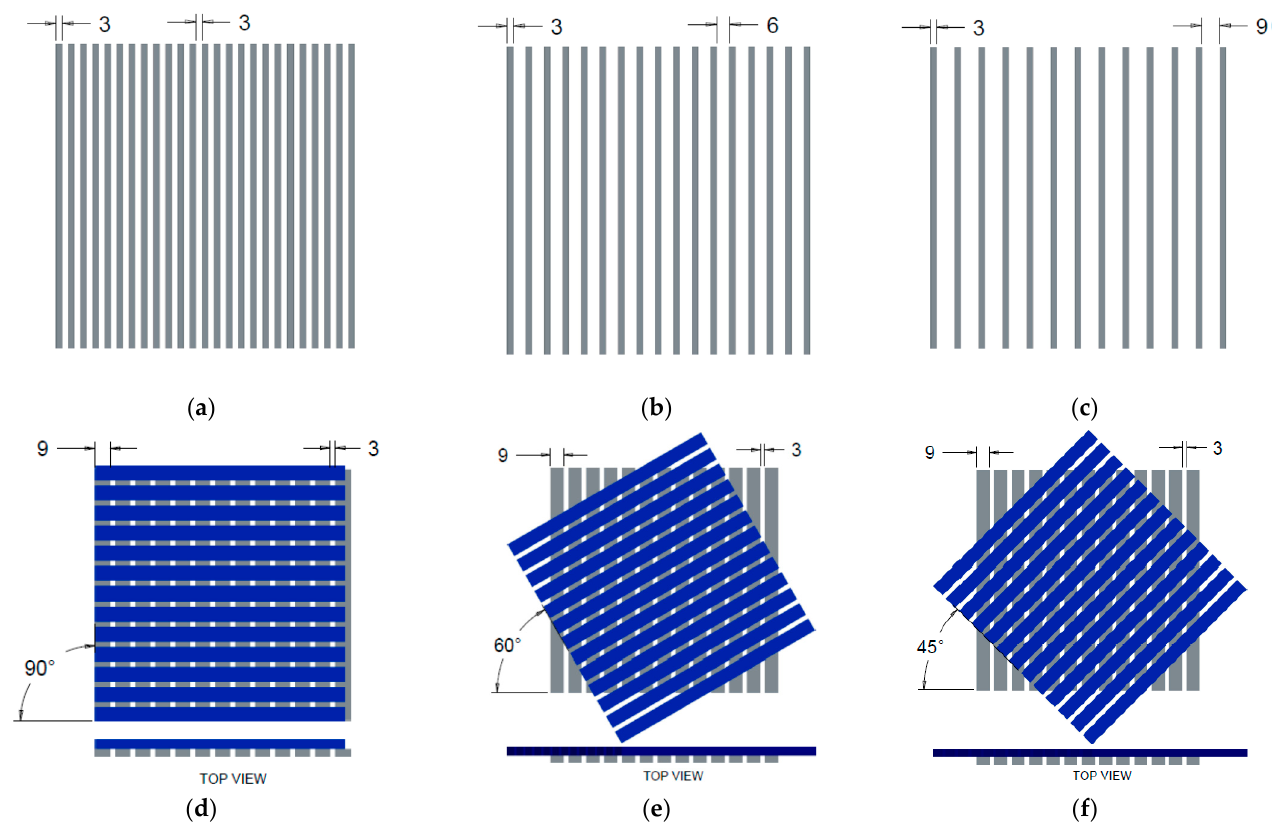
Figure 2. The graphical images of the single-layer Cu/Ni NW strips of 3 mm thickness at distance ( a ) 3 mm (SS30) ( b ) 6 mm (SS60) and ( c ) 9 mm (SS90) and two-layer Cu/Ni NW strips of 9mm thickness laid at ( d ) 90° (TL390) ( e ) 60° (TL360) and ( f ) 45° (TL345) angles.